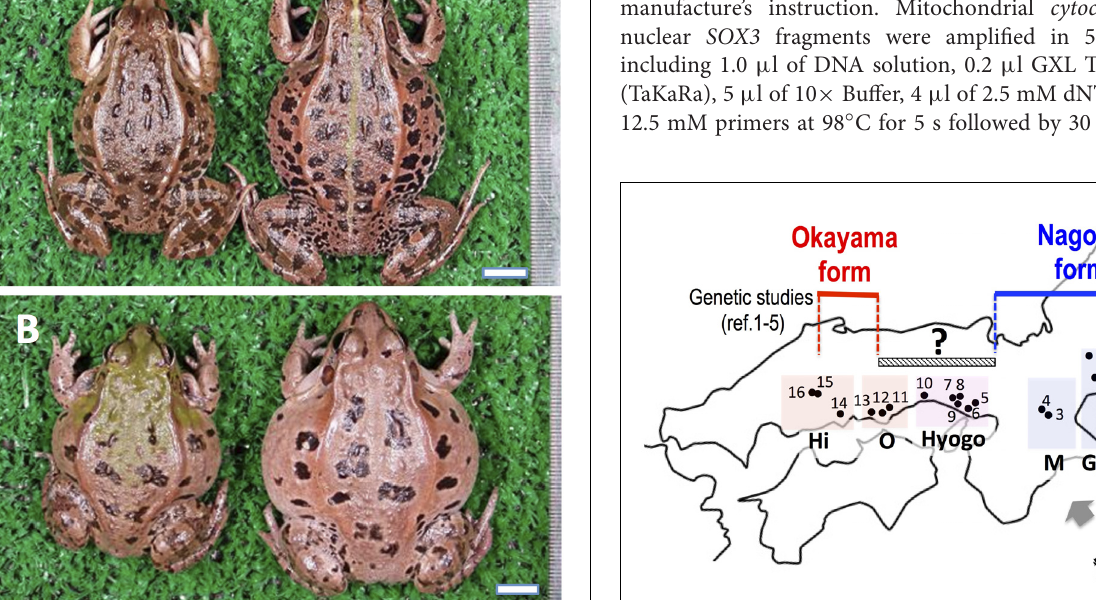
FIGURE 1 | External appearance of Pelophylax porosus brevipodus belonging to the two local forms. (A) The Nagoya form and (B) the Okayama form. Males and females are placed on the left and right, respectively. Central line on the back is seen in the female of Nagoya form. The line is absent in all frogs of Okayama form ever examined. The black spots on the back are larger and lower in number in the Okayama form than Nagoya form.